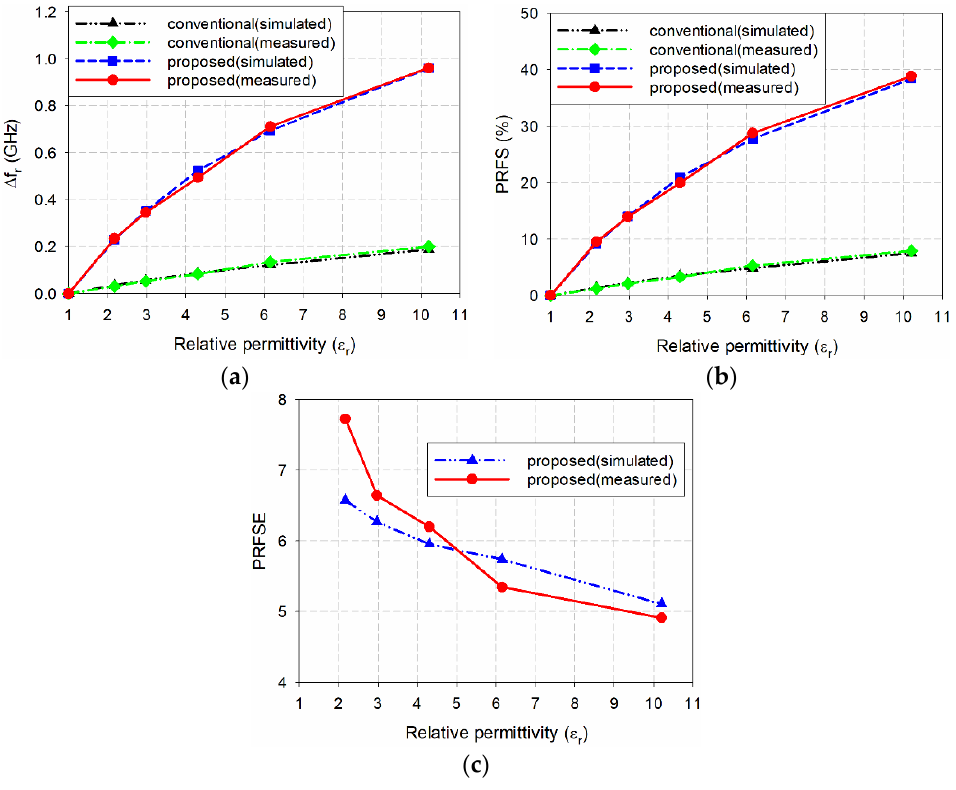
Figure 14. Simulated and measured performance comparison of the two MPSAs for the MUTs in Table 2: ( a ) Δ f r ; ( b ) PRFS; and ( c ) PRFSE. Table 2: ( a ) ∆ f r ; ( b ) PRFS; and ( c ) PRFSE.